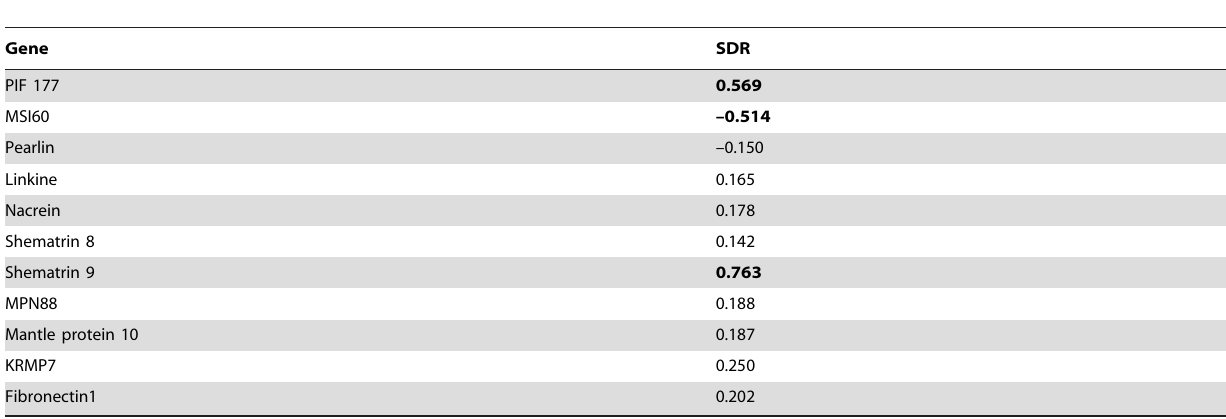
Table 3. Spearman’s coefficient correlation rho between relative matrix gene expression and SDR.